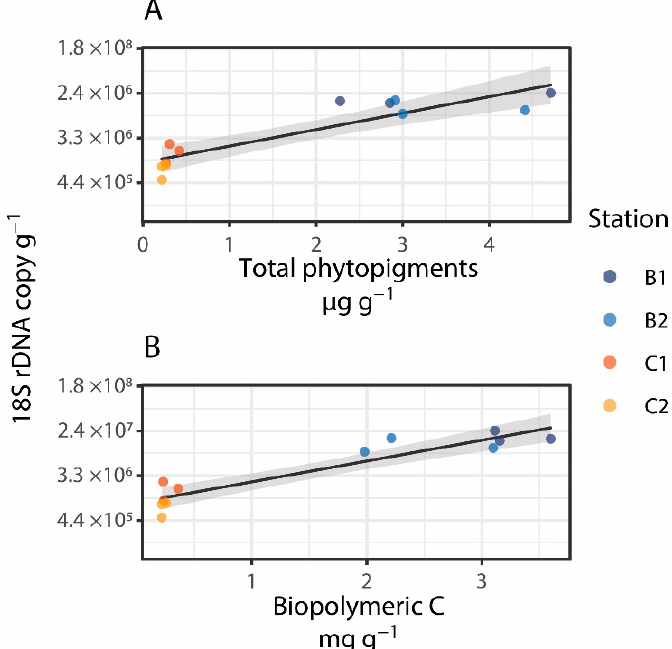
Figure 3. Relationships between fungal abundance (expressed as the number of 18S rDNA copies per gram of dry sediment) and total phytopigment ( A ) and biopolymeric C ( B ) concentrations in the study area. Gray shade represents the 95% confidence interval of the linear model interpolating the observations.